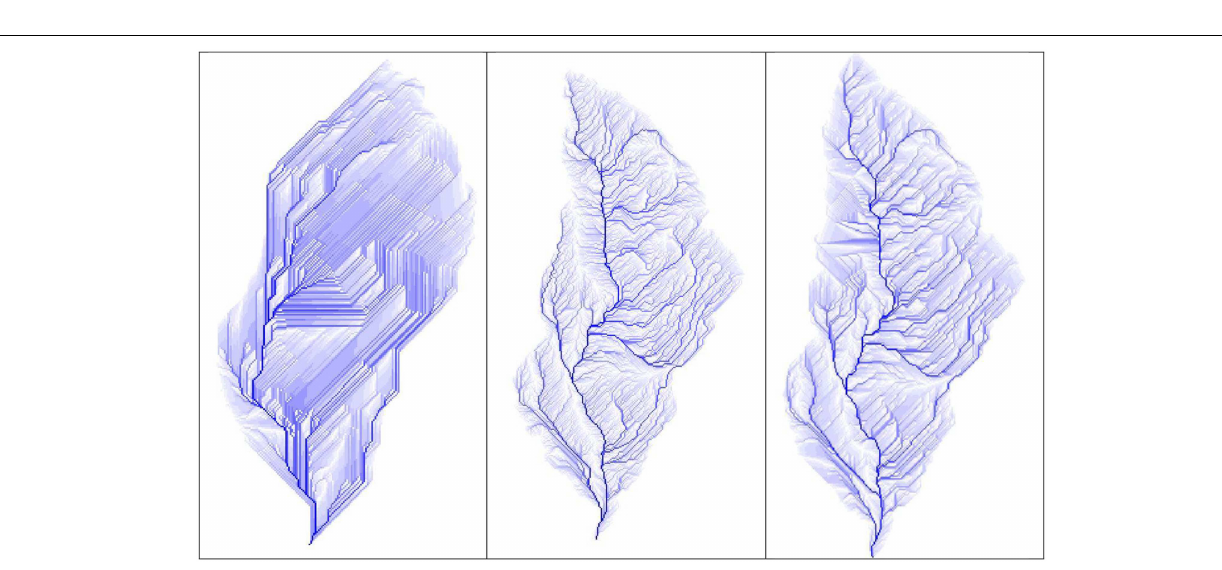
FIGURE 9 | Drained area of Dimai basin provided by RTM (left), Lidar2010 (middle) and Lidar2011 (right) based DEMs.